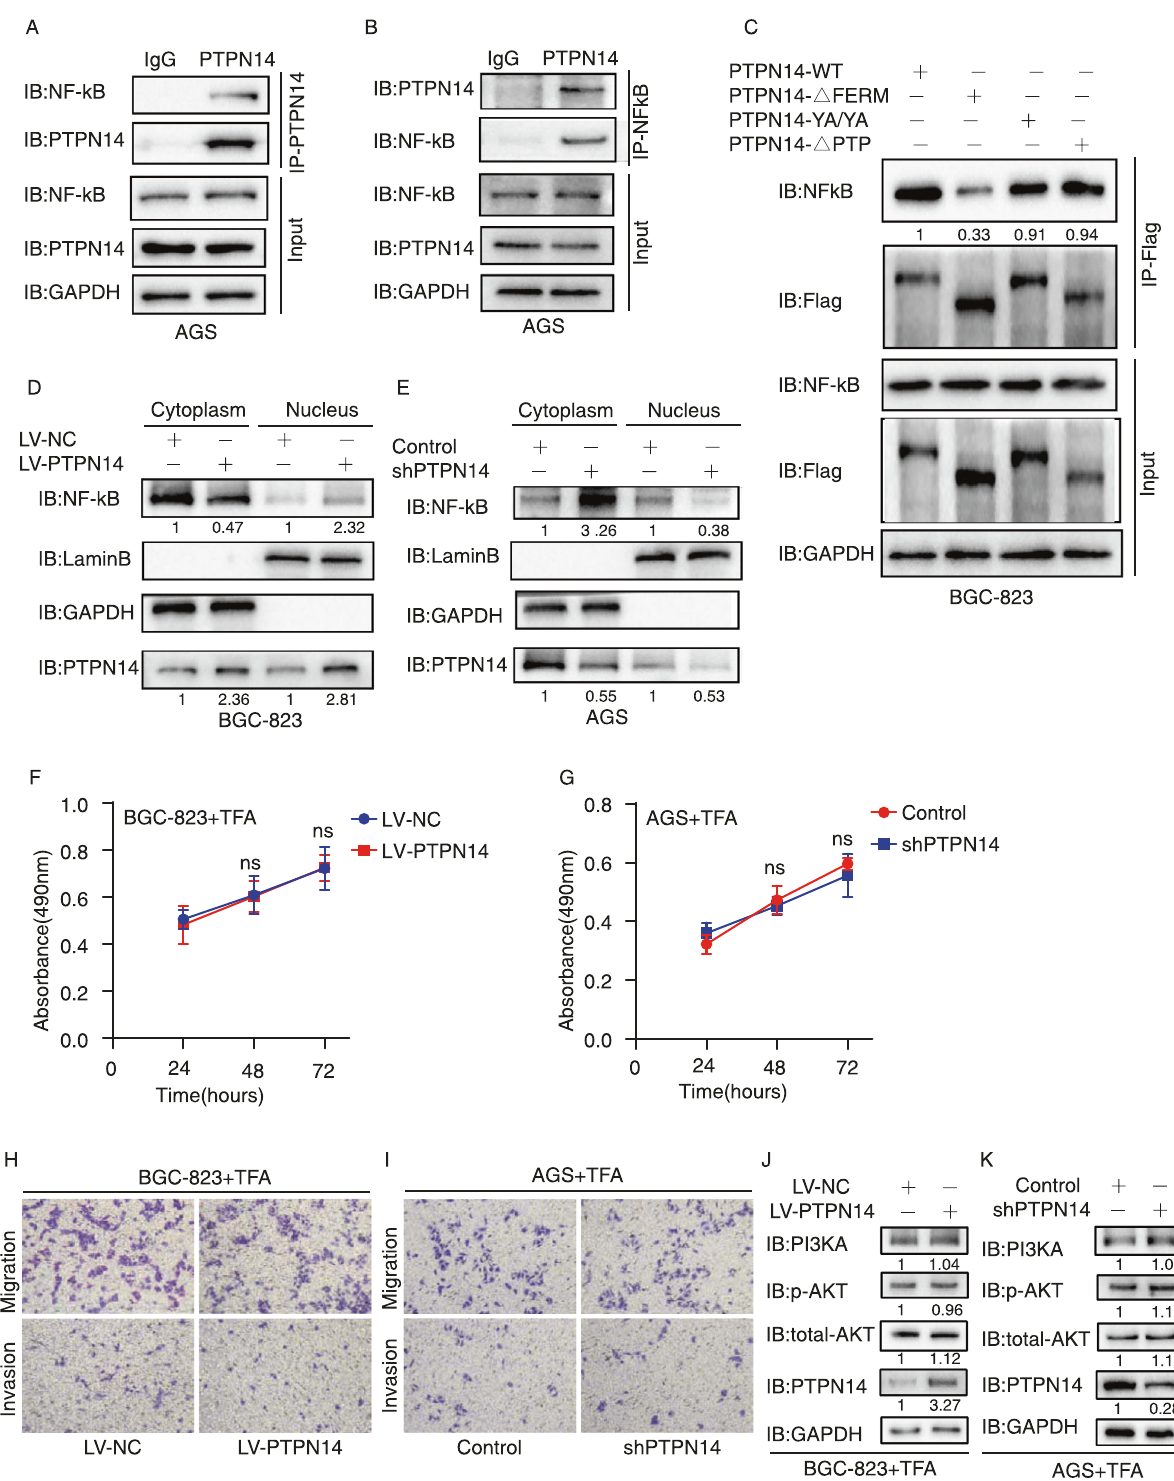
Fig. 6 PTPN14 regulates the PI3KA/AKT pathway through NFkB nucleus translocation. A , B The CO-IP results showed that PTPN14 interacted with NFkB. C The CO-IP assays by PTPN14 truncated plasmids showed that the amount of NFkB binding with PTPN14- Δ FERM was much lower than PTPN14 wild type. D , E The nucleus and cytoplasm separation assays showed that the amount of NFkB in the nucleus was increased in BGC-823 cells by PTPN14 overexpressing ( D ) and the amount of NFkB in the nucleus was decreased in AGS cells by PTPN14 reduction ( E ). F , G After incubating with PTD-p65-P1 Peptide TFA in BGC-823 cells ( F ) and AGS cells ( G ), alteration of PTPN14 expression did not in fl uence cell proliferation. H , I In BGC-823 cells ( H ) and AGS cells ( I ) incubating with PTD-p65-P1 Peptide TFA, the migrating or invading cell numbers were not altered by the PTPN14 expression level. J , K After incubating with PTD-p65-P1 Peptide TFA in BGC-823 cells ( J ) and AGS cells ( K ), alteration of PTPN14 expression did not in fl uence the PI3KA/AKT pathway.